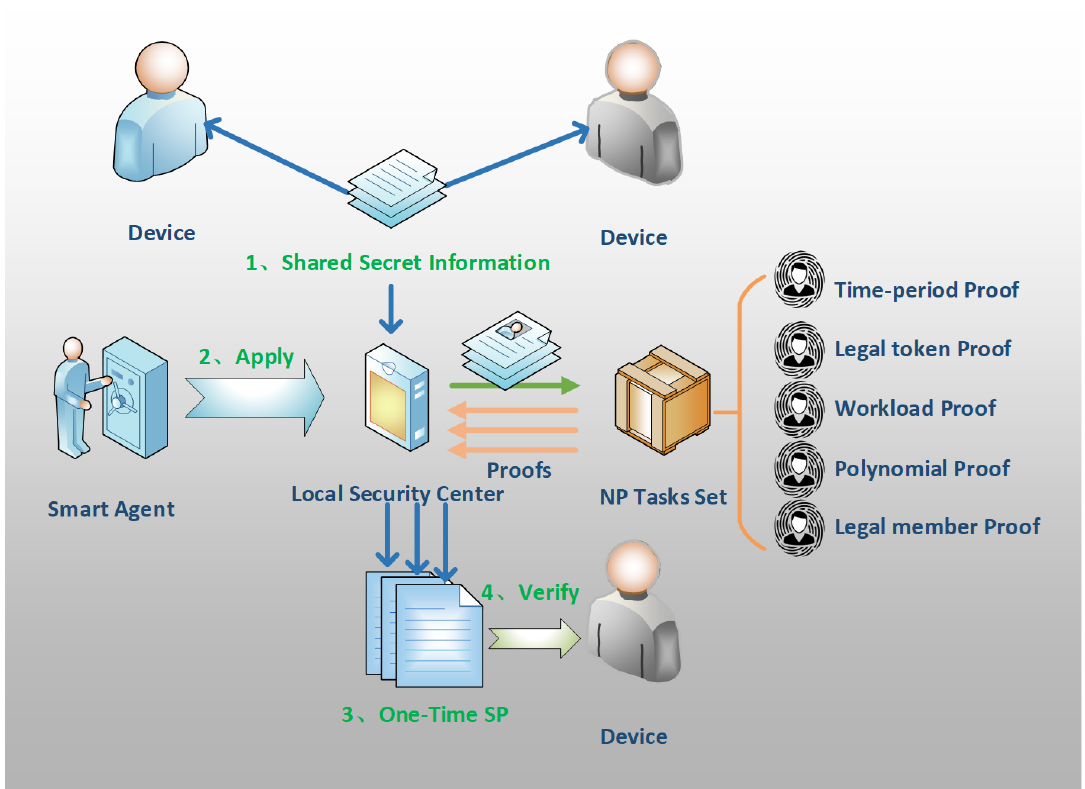
Figure 2. One-time association multitasking proofs for peer to local authentication (OTMP-P2L) processing procedure. Nondeterministic polynomial